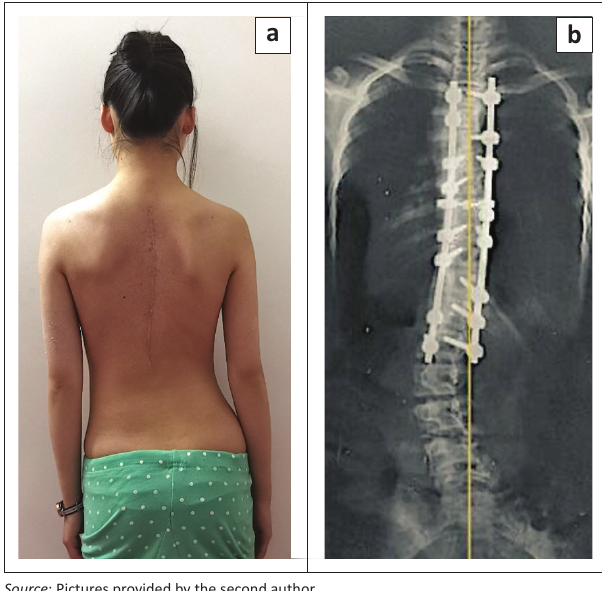
FIGURE 4: (a) Dorsal double rod instrumentation with full correction of a main thoracic curve initially exceeding 50°. (b) The unfused short lumbar counter- curve to the left post-surgery leads to a decompensated posture with pelvic prominence on the right.